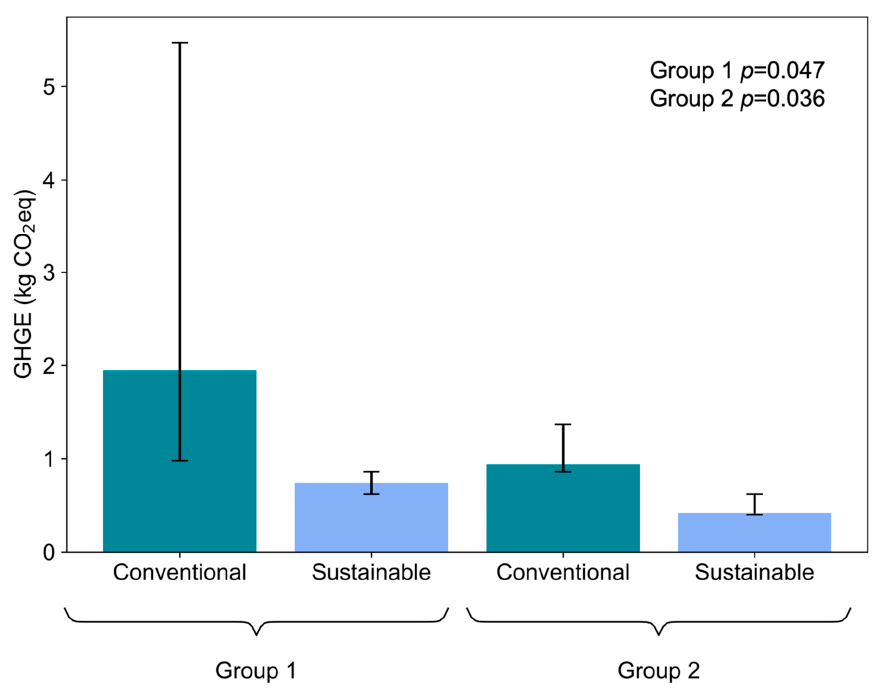
Figure 4. The GHGE value between sustainable and conventional school food menus. The GHGE expressed per year in kg CO 2 e for the two different food menu types targeted in this study. The graph shows the p value for both groups, and the error bars represent p 25, p 75 for each school food menu. See Section 2.1 for the classification of groups.